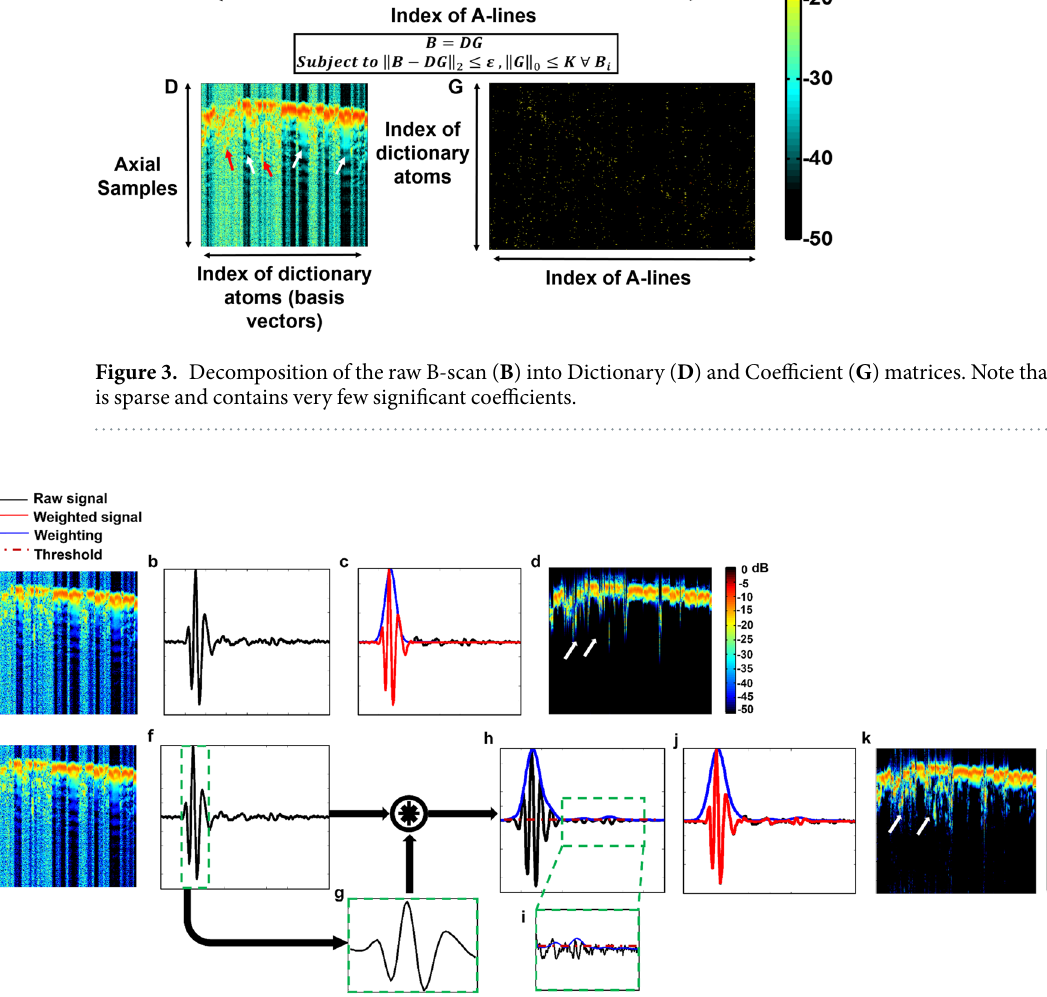
accurately captures the reverberant artifacts (white arrows) and signals of smaller amplitude (red arrows) and the matrix ( G ) is sparse. Algorithm performance. A common initialization for the K-SVD algorithm, using randomly selected samples of the data itself as the initial dictionary, rather than an established basis such as the Fourier, cosine or wavelet bases, was used 10 . This initialization method has its origins in the K-SVD being a generalization of the K-means algorithm, which obtains feature/dictionary vectors using the expectation minimization algo- rithm—a specific instance of the more general alternating minimization method. The K-SVD algorithm has a natural noise reducing property (Figure S1), since it seeks to find features common to the coded signals during the update step. Naturally uncorrelated white Gaussian noise is reduced first during the sparse coding process and then dur- ing the rank one update step described in preceding section. Applying the K-SVD algorithm with a well-tuned